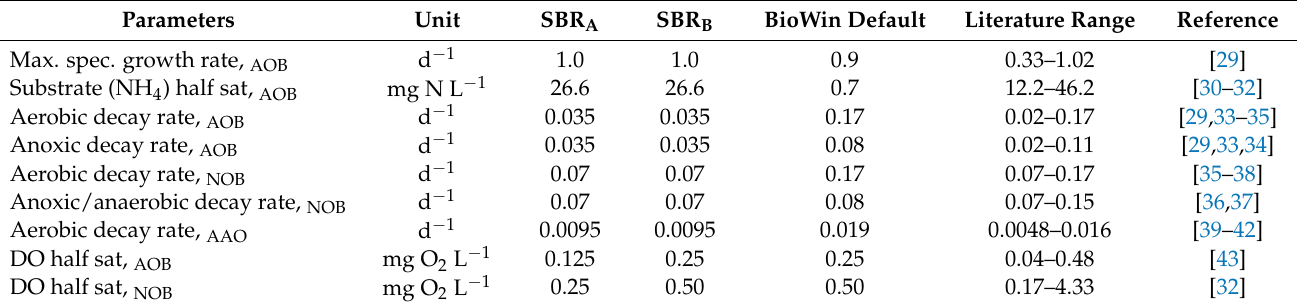
Table 5. Parameter values adjusted during model